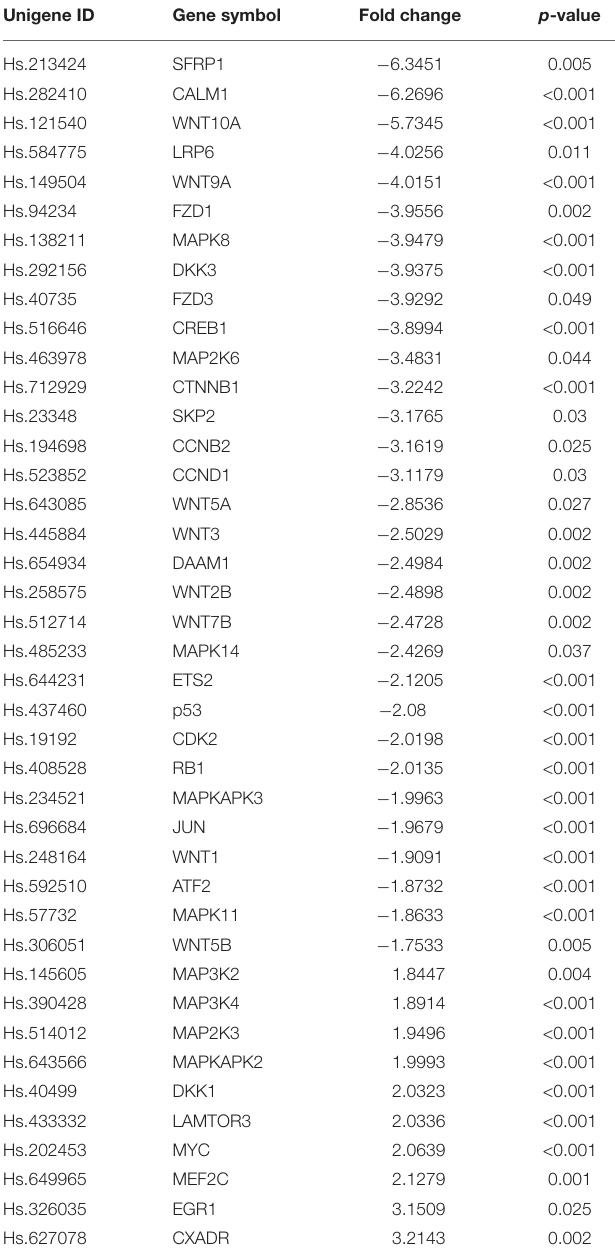
TABLE 2 | Fold regulation comparison and p -value for genes within the human Wnt signaling and related pathways in human astrocytes under hypoxia with or without hypothermic intervention (a full list of all the investigated genes is provided in Supplementary Tables 2,3). Unigene